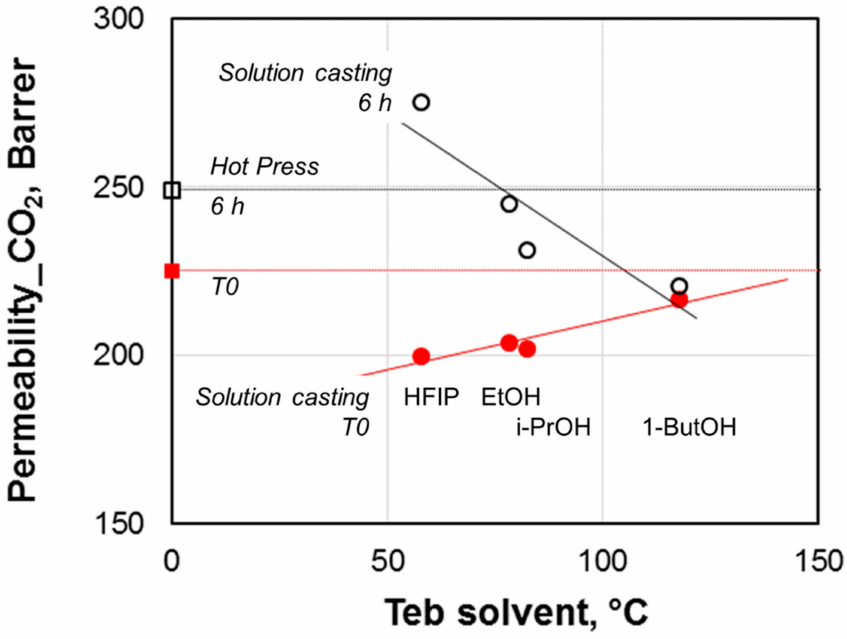
Figure 7. CO 2 permeability in Pebax ® 2533 films produced from different solvents as a function of the solvent boiling point. Circles: data for the films prepared by solvent evaporation; squares: data for the films prepared by the hot press method. Filled symbols: data for ‘as prepared’ (T0) films; open symbols: data for photo-oxidated films (6